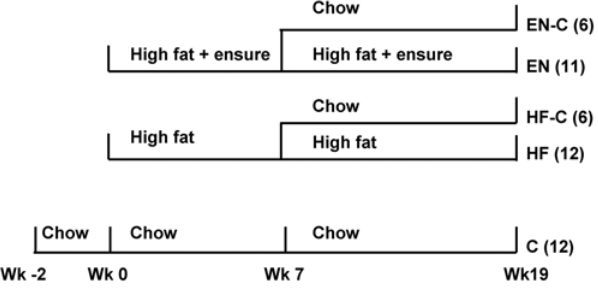
Figure 1. Experiment design. For the first 7 weeks two groups of weight-matched mice were fed different obesigenic diets, either a high fat solid diet or a high fat solid diet plus liquid Ensure. Subsequently, 6 mice from each group that were fed the obesigenic diets were switched to the standard chow diet for the remaining 12 weeks. All food and liquid intake was ad